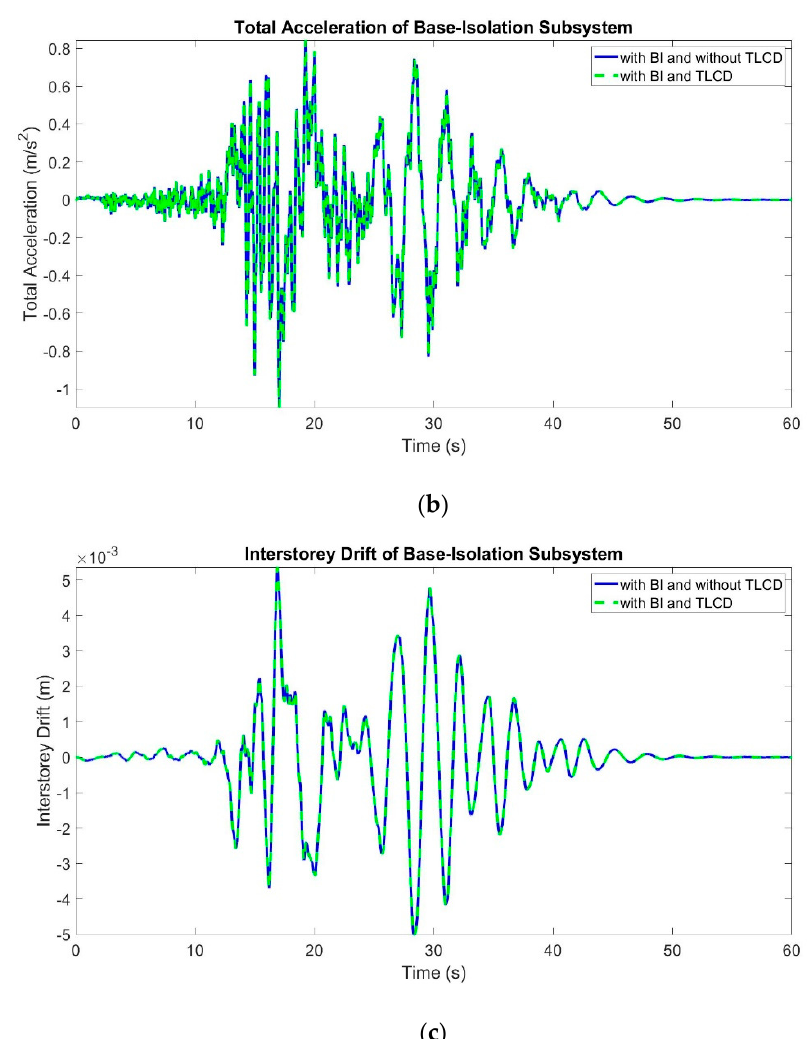
Figure 9. Response time histories of base level for the earthquake-prone simple uncontrolled structure, base-isolated structure, and hybrid-controlled structure no. 21 record: ( a ) displacement; ( b ) total acceleration; ( c ) interstory drift.